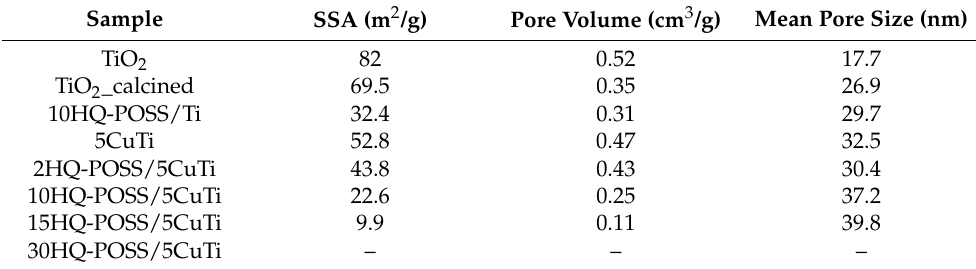
Table 3. BET specific surface areas, pore size distributions, and pore volumes of the materials (see Supplementary Materials, Figures S6 and